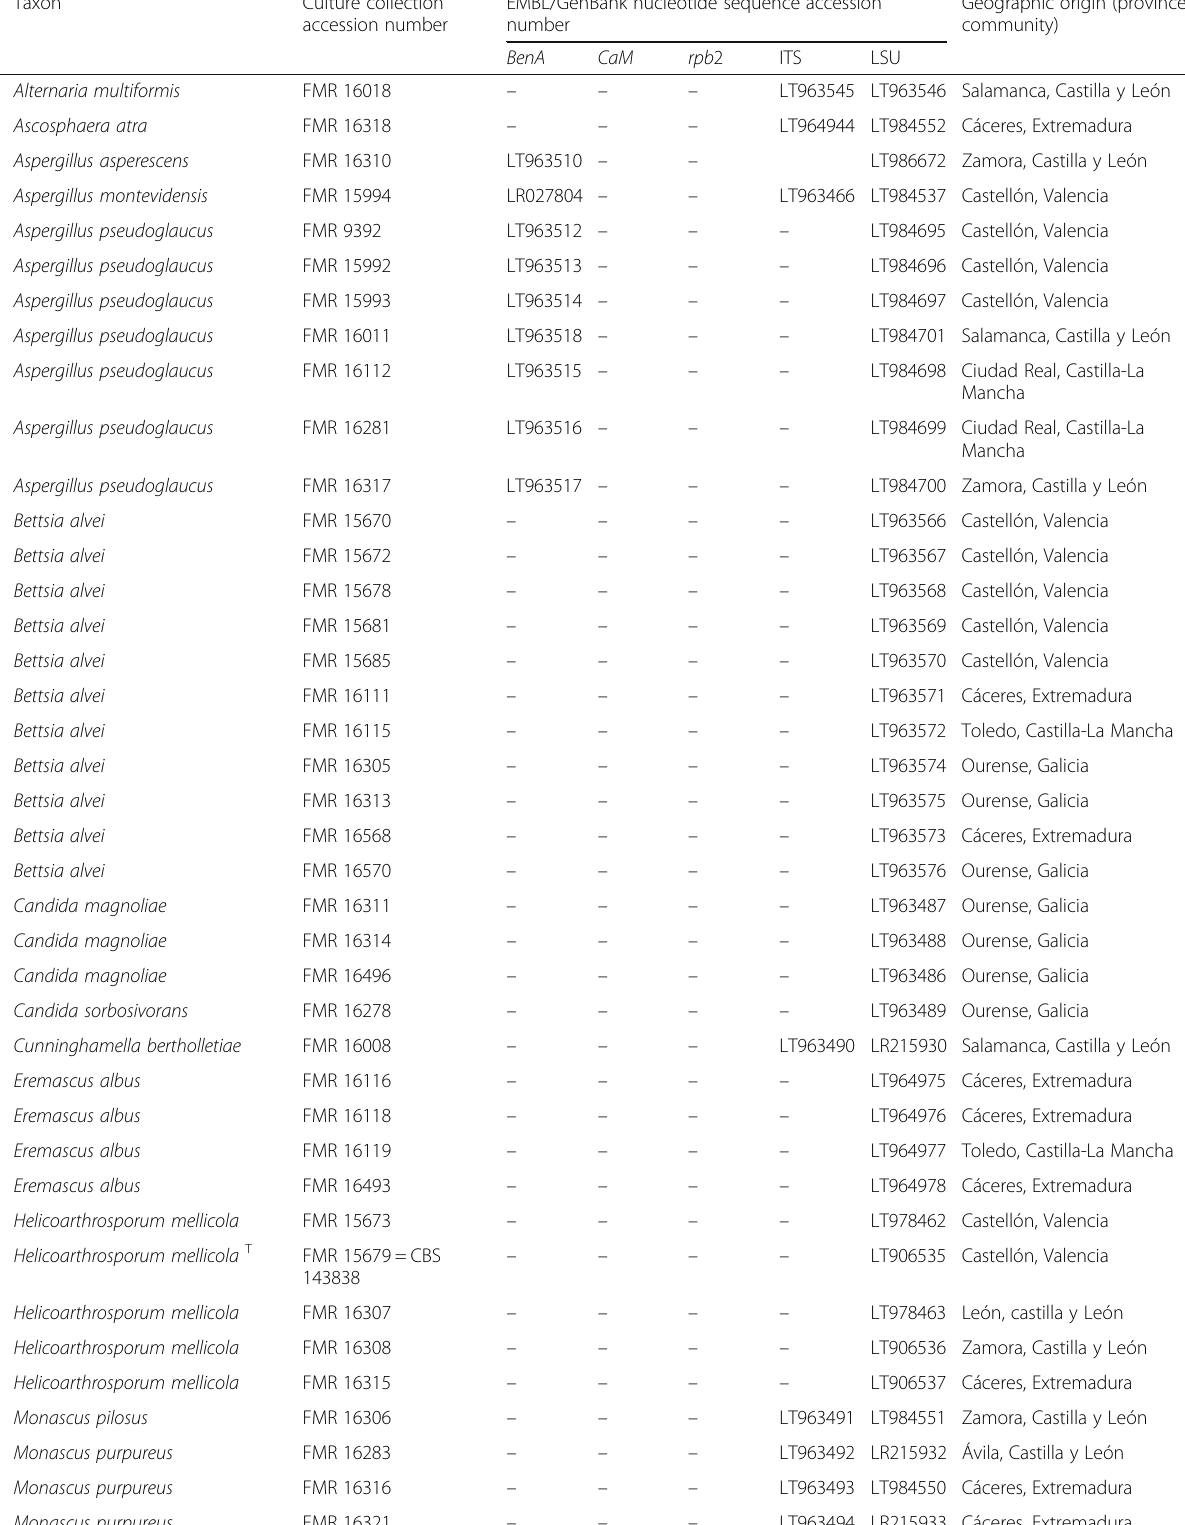
Table 1 Fungal taxa recovered with their nucleotide sequence accession number, and the geographic origin of the honey samples